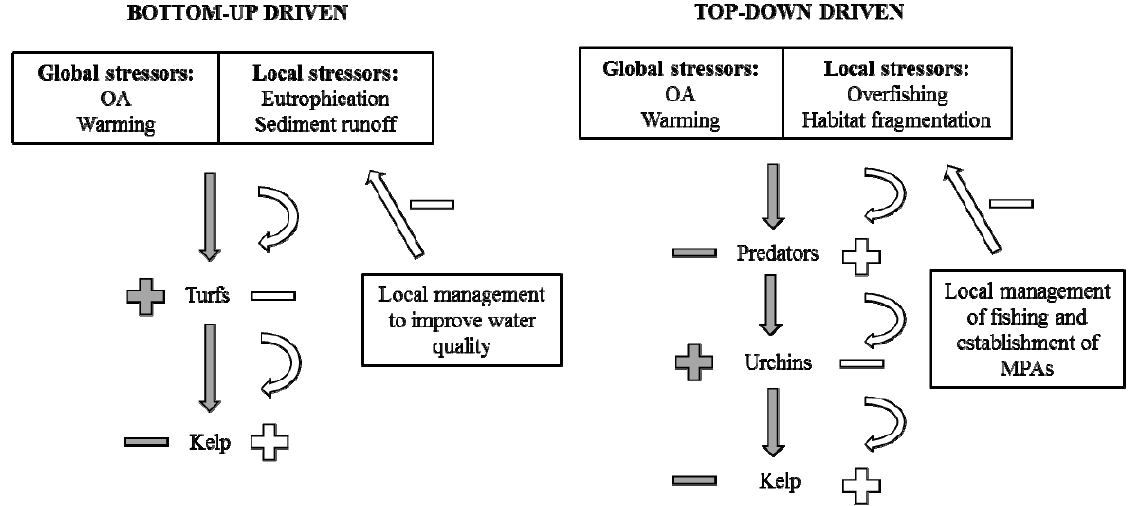
Figure 1. Schematic representation of how local management could act to reduce local stressors, potentially disrupting synergies with global